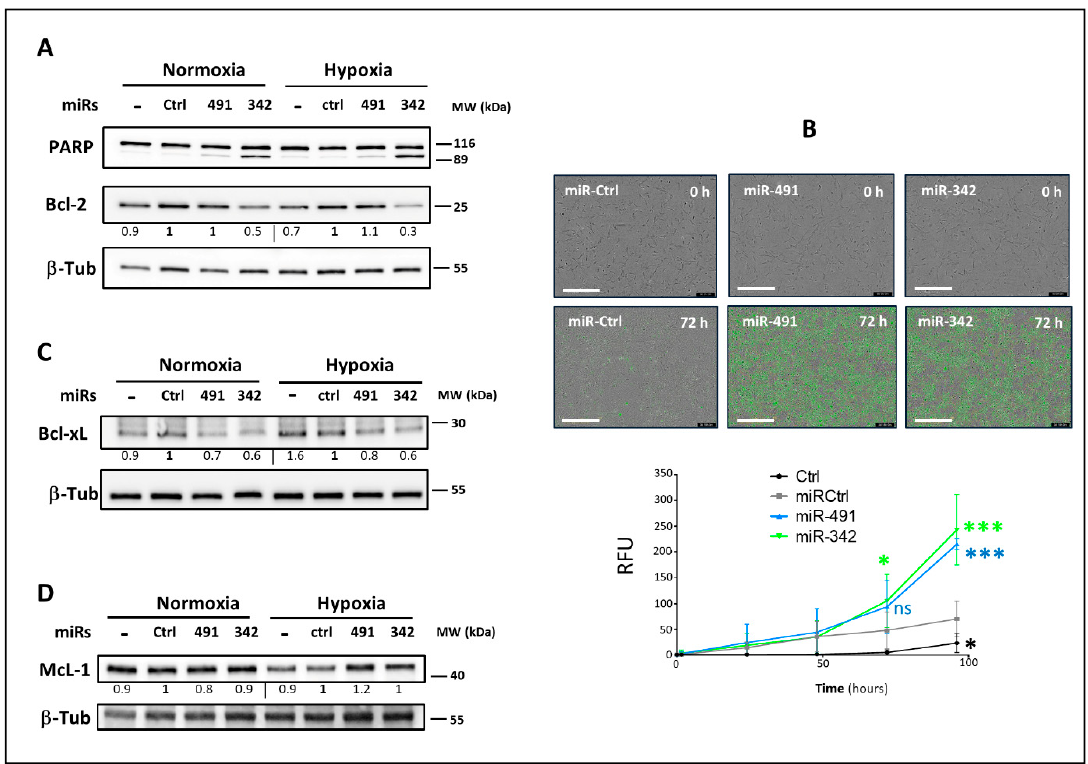
Figure 5. Analysis of the apoptotic effects of miR-491-5p and miR-342-5p on SW1353 cells. In parts ( A , C , D ), SW1353 cells were cultured under normoxia or hypoxia. They were transfected 24 h after seeding with 20 nM of miR-Ctrl, miR-491-5p or miR-342-5p. Analyses were carried out 72 h post-transfection. Protein extracts were analyzed with Western blots to evaluate PARP, Bcl-2, Bcl-xL and McL-1 levels versus a β -tubulin ( β -Tub) loading control. Representative blots of three independent experiments are shown. Protein expressions are indicated at the bottom of the blots. They were normalized to β -tubulin and to the corresponding miR-Ctrl for each oxic condition. ( B ) SW1353 cells were cultured under normoxia and transfected 24 h after seeding as before. Caspase-3/7 activity was then assessed in real time for 96 h, as described in the Materials and Methods section. The images shown are representative of the experimental results obtained. Scale bar: 400 µm. The graph provides the analysis of fluorescence of four independent experiments (mean RFU ± SD). The significance of the results between miR-Ctrl and miRNA-treated cells was assessed using two-way ANOVA (*: p < 0.05, ***: p < 0.001).